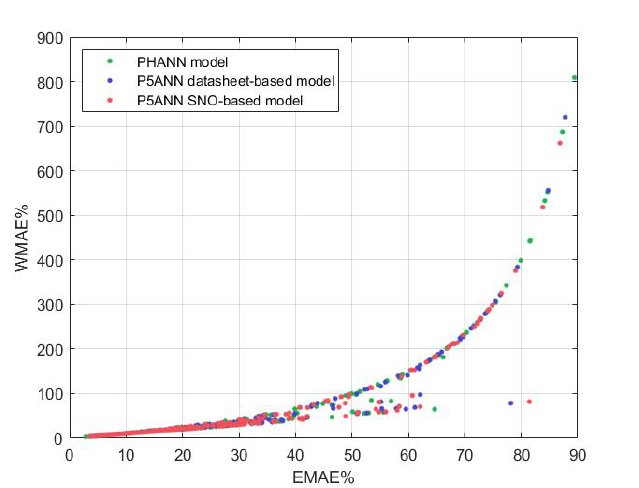
Figure 11. Scatterplot of EMAE and WMAE values obtained from the three hybrid